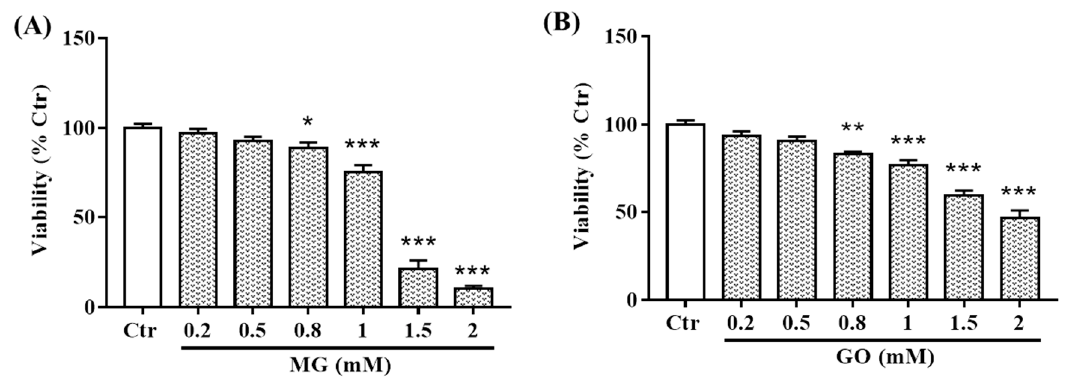
Figure 3. Effects of MG and GO on the survival of SK-N-SH neuronal cells. Cells were treated for 24 h with different concentrations (0.2–2 mM) of MG ( A ) and GO ( B ). Cell survival was analyzed by Resazurin assay. The results are expressed as a percentage of control, non-treated cells (considered as 100%). Values are mean ± S.E.M from at least three separate experiments performed in sextuplicate in each group with * p < 0.05, ** p < 0.01, *** p < 0.001 versus control cells. Data groups were compared with one-way ANOVA followed by the Dunnett’s post hoc test.